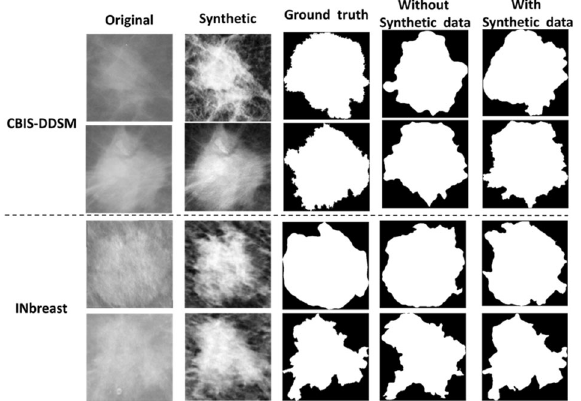
Fig. 6 Examples of the segmentation results for the proposed architecture Connected-ResUNets with and without adding the synthetic data. Subplot on the top shows two samples of mammograms from the CBIS-DDSM dataset. Subplot on the bottom shows two samples of mammograms from the INbreast dataset. Each rows indicate original mammogram, its corresponding synthetic mammogram, ground-truth (binary) image, segmentation output image of the Connected-ResUNets model trained without adding synthetic data, and segmentation output image of the Connected-ResUNets model trained with adding synthetic